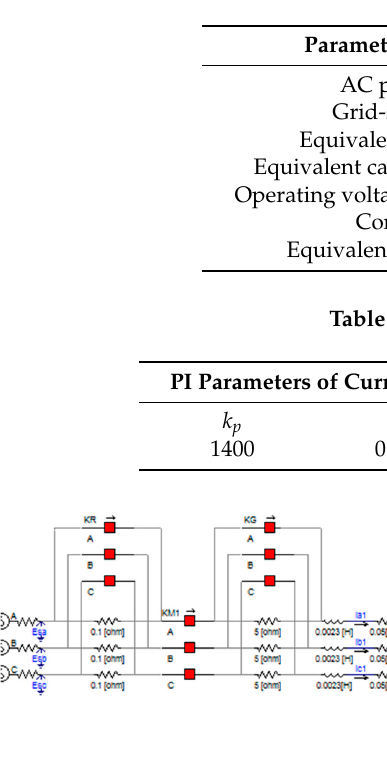
Figure 9. Simulation platform based on PSCAD/EMTDC.